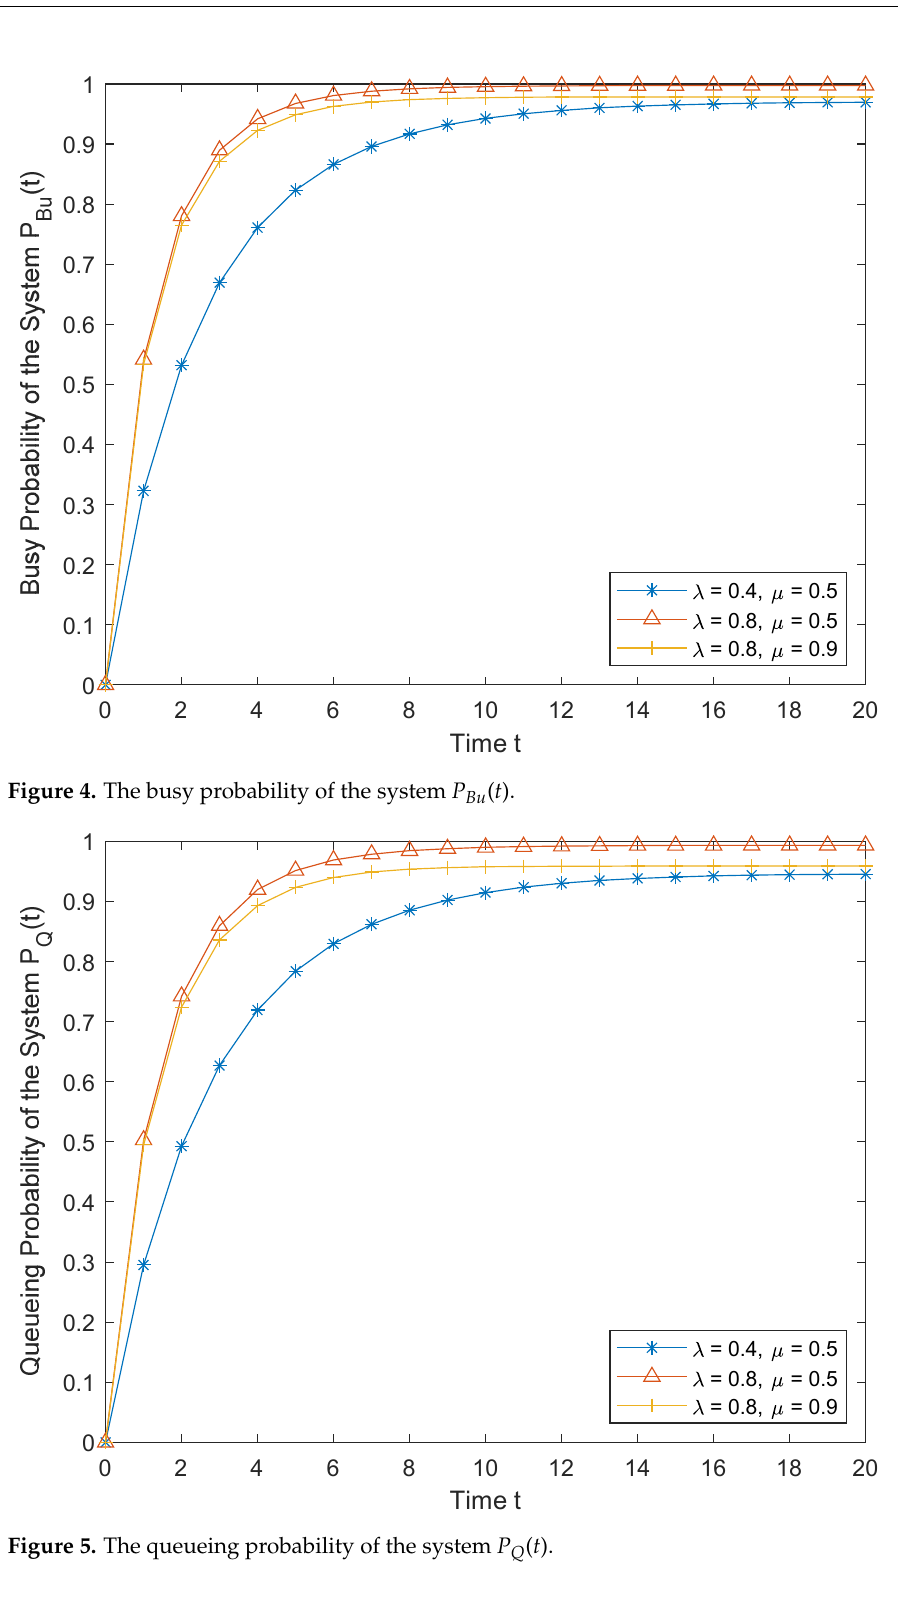
Figure 6. The mean number of customers in the system L S ( t ). Figure 7. The mean number of customers in the queue L Q ( t ).